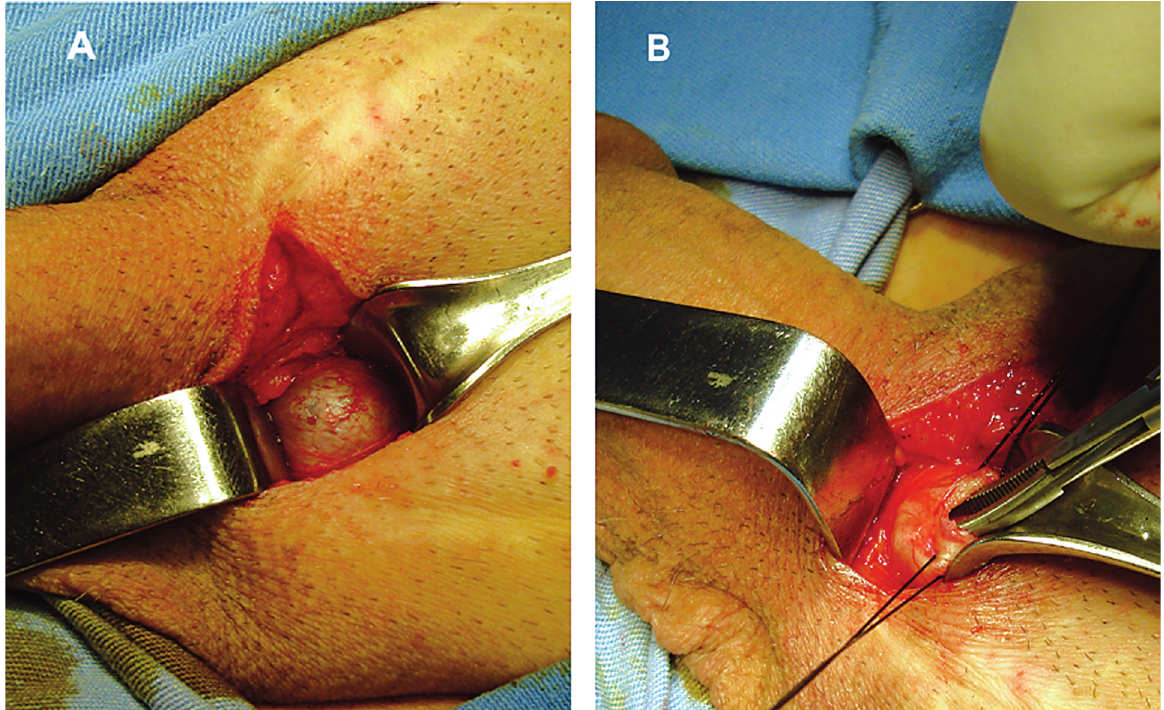
Figure 2 – Identification and incision of the corpus